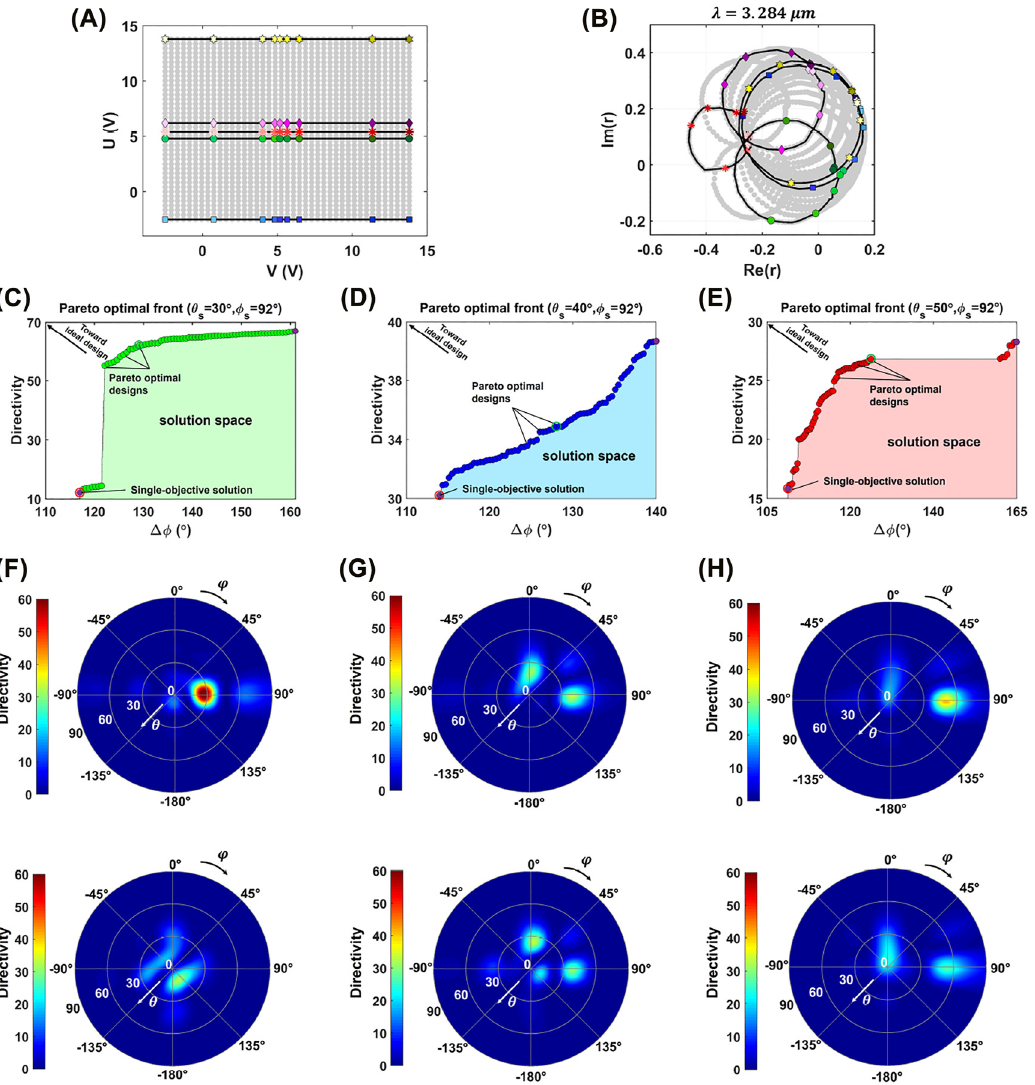
Figure 4: Inverse design of the perimeter-controlled beam steering metasurface. (A) The DC voltage space consisting of all possible combinations of the bias voltages V and U that are independently applied to the top and bottom electrodes. (B) The distribution of the reflection coefficient at the complex r -plane at the operating wavelength of 𝜆 = 3.284 μ m that are resulted by application of the bias voltage combinations in (A) to the metasurface. The highlighted trajectories in (B) correspond to the color-coded lines at the bias voltage space in is adjusted to 92 ◦ and 𝜃 is set (A). Depiction of the solution space generated by multi-objective optimization when the steering angle of 𝜑 s s to the values (C) 30 ◦ , (D) 40 ◦ , and (E) 50 ◦ . The horizontal and vertical axes denote the deviation of the desired spatial phase from the obtained one and the directivity, respectively. The corresponding directivity patterns of the perimeter-controlled metasurface that are = 30 ◦ ,𝜑 = 92 ◦ , (G) 𝜃 = 40 ◦ ,𝜑 = 92 ◦ , and (H) 𝜃 = 50 ◦ ,𝜑 = 92 ◦ . In (F)–(H), the figures at the top calculated for the steering angles (F) 𝜃 s s s s s s and bottom rows respectively correspond to the multi-objective optimizer solutions that are identified by green circles and single objective optimizer solutions depicted by red circles in the Pareto optimal